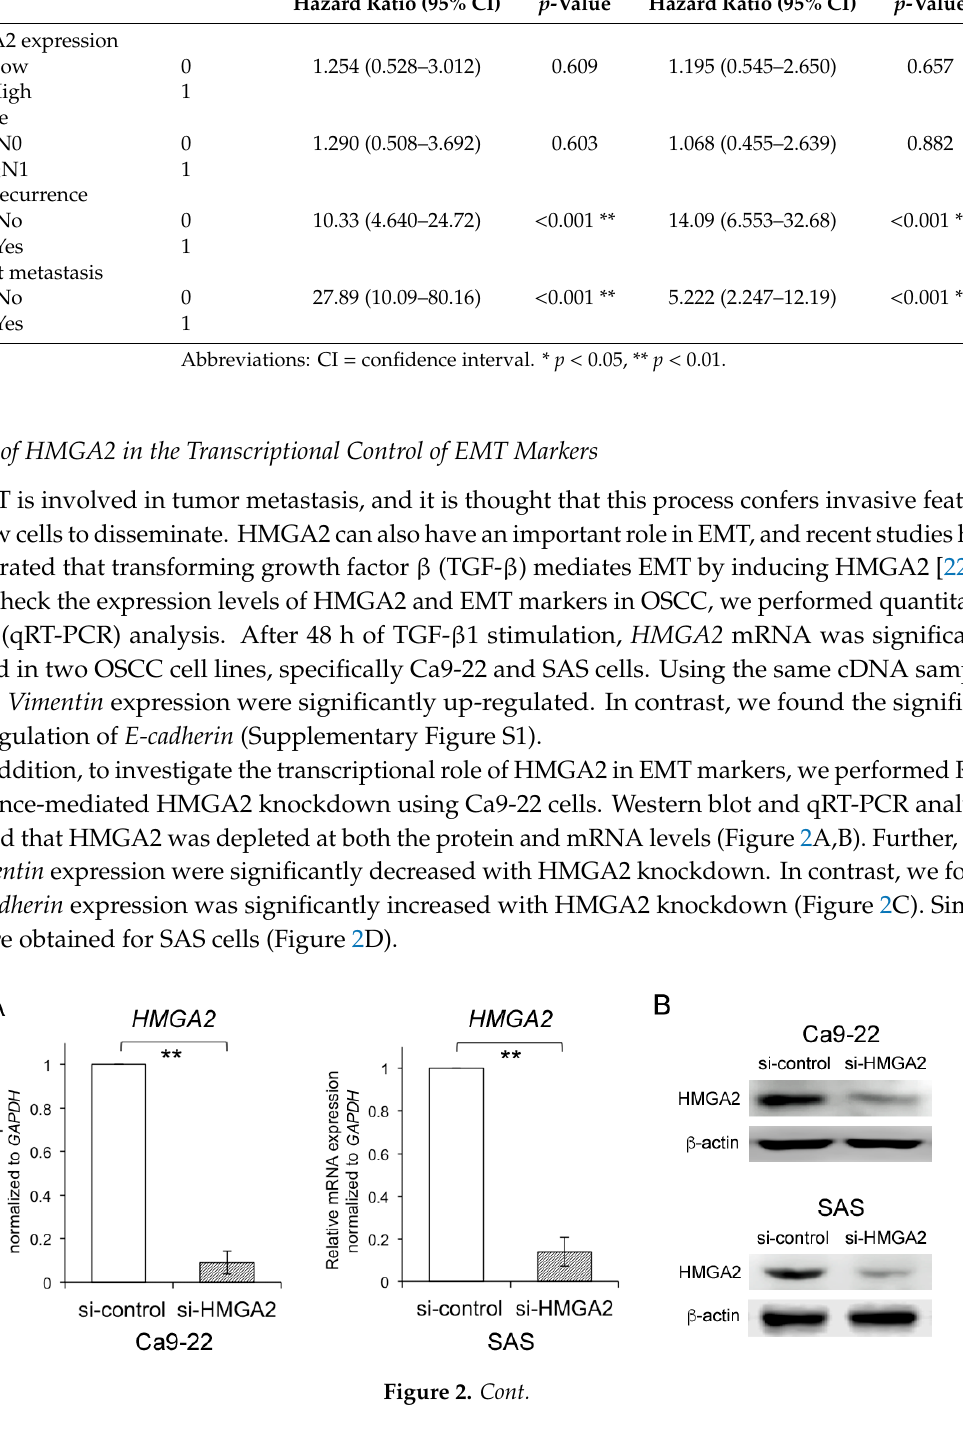
Figure 2. HMGA2 controls the expression of epithelial–mesenchymal transition (EMT) markers in oral squamous cell carcinoma (OSCC) cell lines. ( A , B ) The mRNA and protein expression levels of HMGA2 in Ca9-22 cells and SAS cells transfected with HMGA2 siRNA or control. Total RNA and whole-cell lysates were used for qRT-PCR ( A ) and western blot analysis ( B ), respectively. ( C , D ) The mRNA expression levels of E-cadherin , Vimentin, and Slug were measured using qRT-PCR with Ca9-